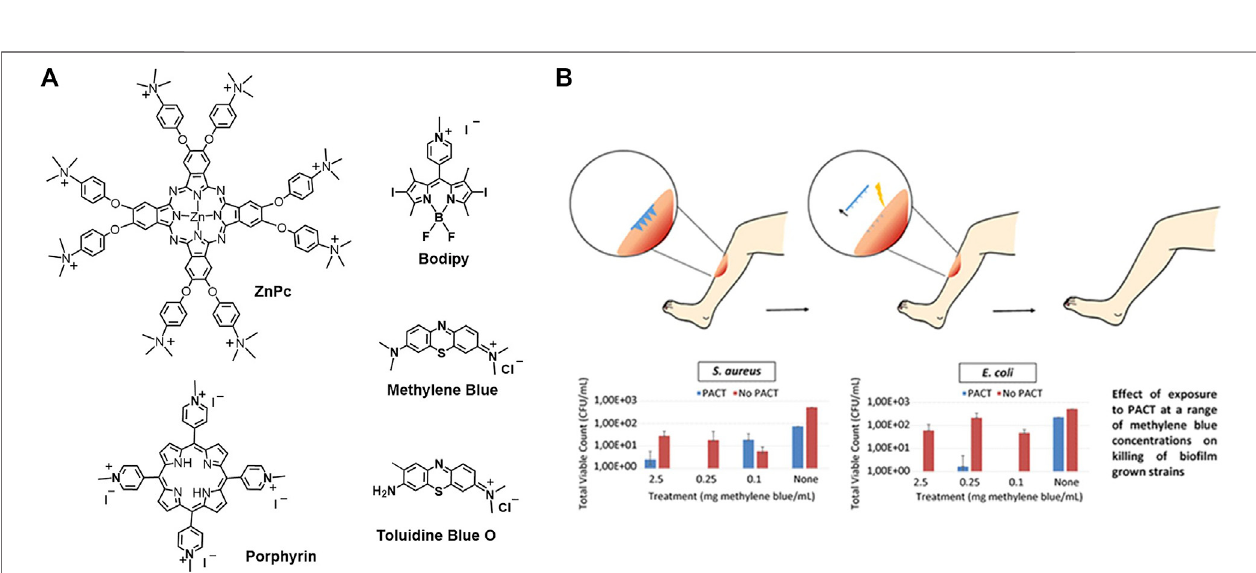
FIGURE11|(A) Molecularstructureofcationicphotosensitizers; (B) methyleneblue-loadedmicroneedleforphotodynamicantimicrobialchemotherapyatarange of methylene blue concentrations on killing of bio fi lm grown strains S. aureus and E. coli (Caffarel-Salvador et al., 2015).